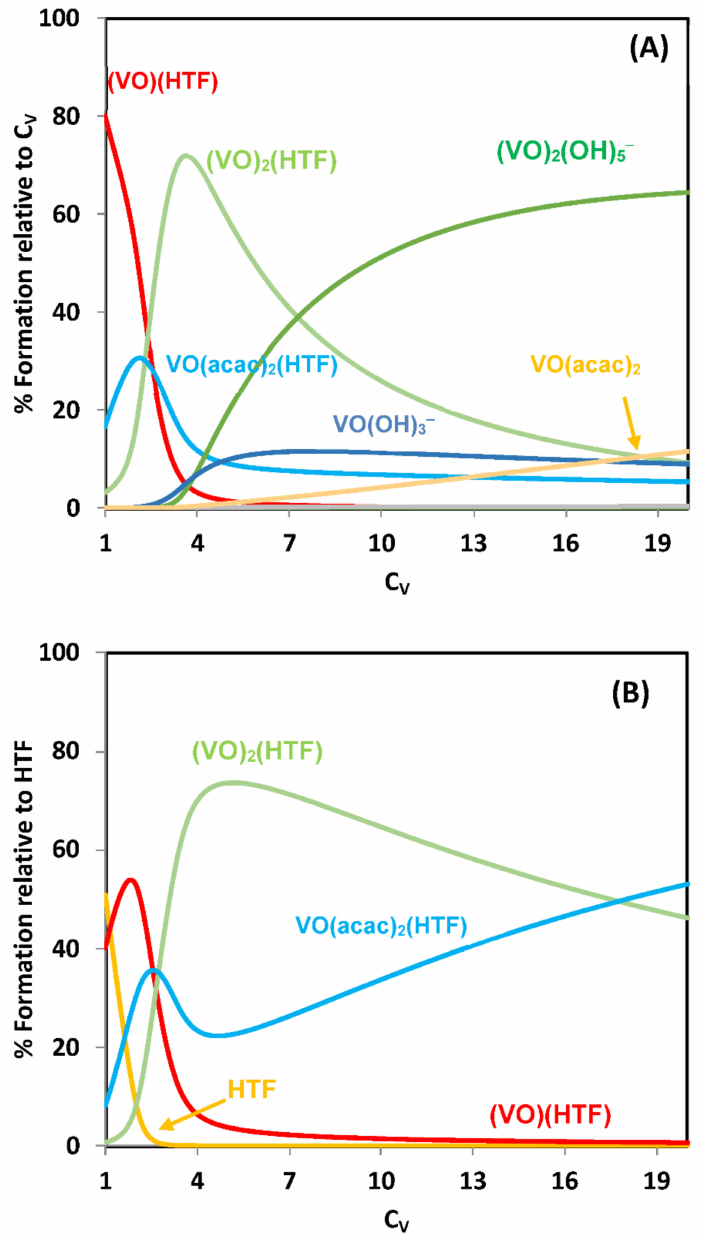
Figure 5. Species distribution diagrams for the system V IV O 2+ + acetylacetone + apoHTF, for [apoHTF]= 2 × 10 − 6 M and [V IV O(acac) 2 ] in the range of 1 to 20 µ M, at pH = 7.4, considering the formation constants reported in [9,15,22,46], and the formation constant of [(V IV O(acac) 2 ) 1 (apoHTF)] (=10 27 ). ( A ) Representation of vanadium containing species; ( B ) Representation of apoHTF containing species. The calculations were carried out with the computer program HySS